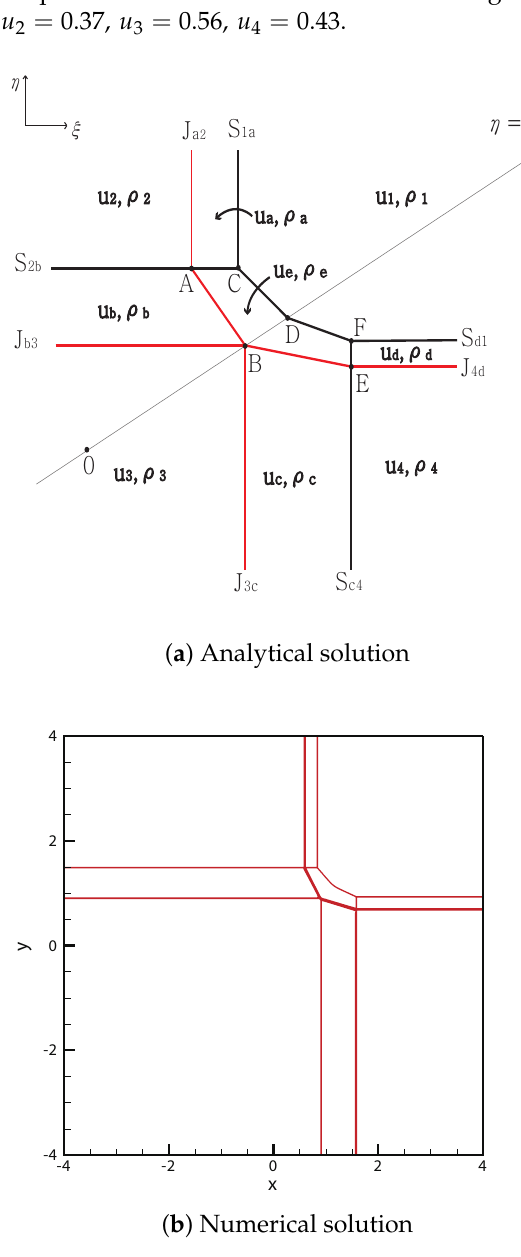
Figure 20. Case 18. SJ + SJ + JS +